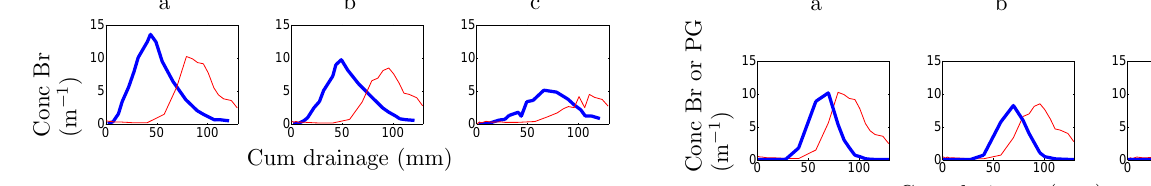
Fig. 9. Breakthrough curves of bromide for the snowmelt experiment (thick blue line) and the irrigation experiment (thin red line), for fast cells (a) , average cells (b) , and slow cells (c) .